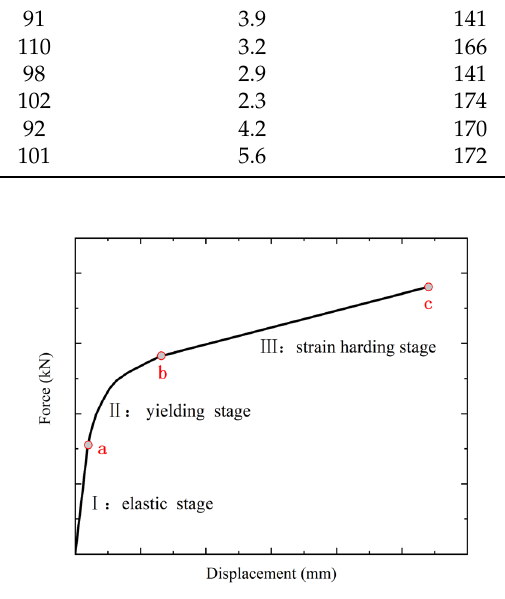
Figure 9. A typical force–displacement curve behavior of a T-stub.